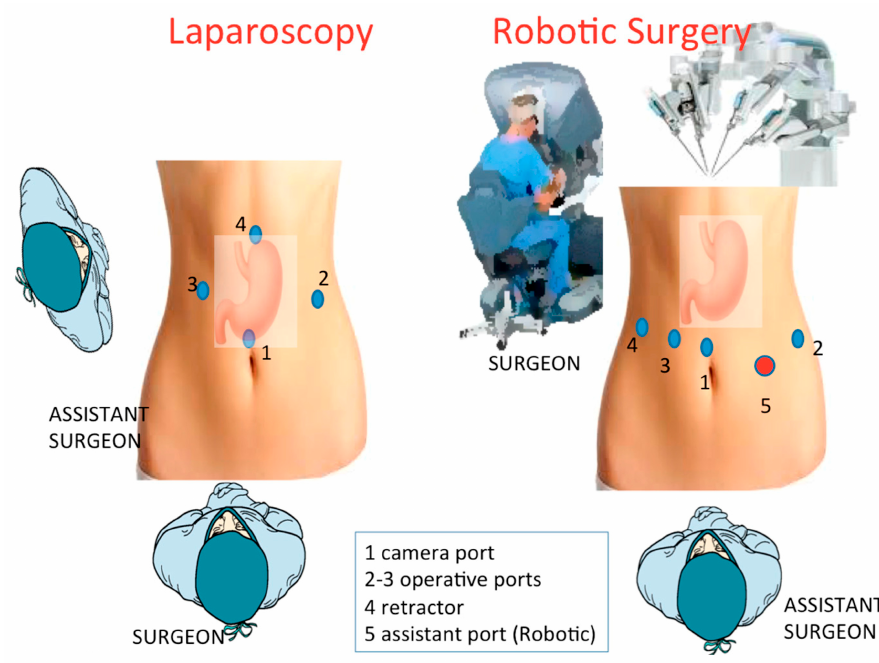
Figure 3. Trocar localization in laparoscopic and robotic approaches.